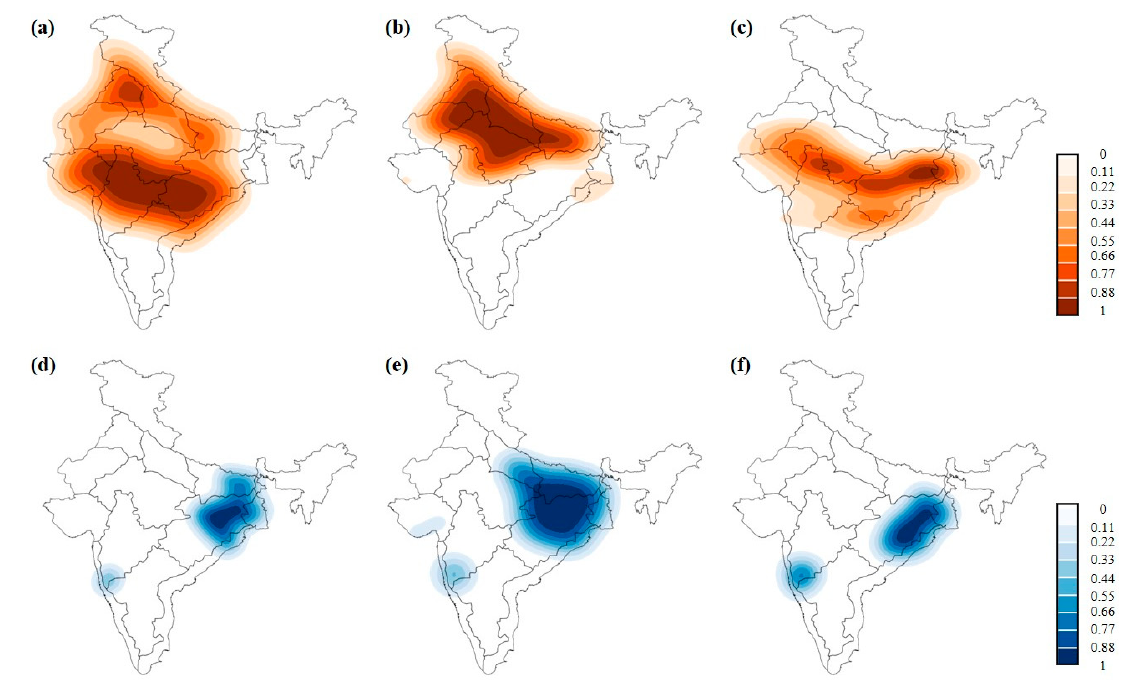
Figure 6. Regions showing statistically significant composite anomalies of specific humidity (kg/kg) across India during the month of June when SST anomalies of the Western Indian Ocean ( a , d ), Northern Indian Ocean ( b , e ) and Central Indian Ocean ( c , f ) demonstrated positive (upper) and negative (lower) variations. The colour bar shows the scaled density estimate of negative (orange) and positive (blue) specific humidity anomalies. The warmer SST in the oceanic regions leads to negative specific humidity anomalies, while the colder SST leads to positive specific humidity anomalies in the shaded areas. (Software used: Python version 3.7 (2019), https://www.python.org/ (accessed on 8 November 2021) and R version 4.0.5 (2021), https://www.R-project.org/ (accessed on 6 November 2021)).